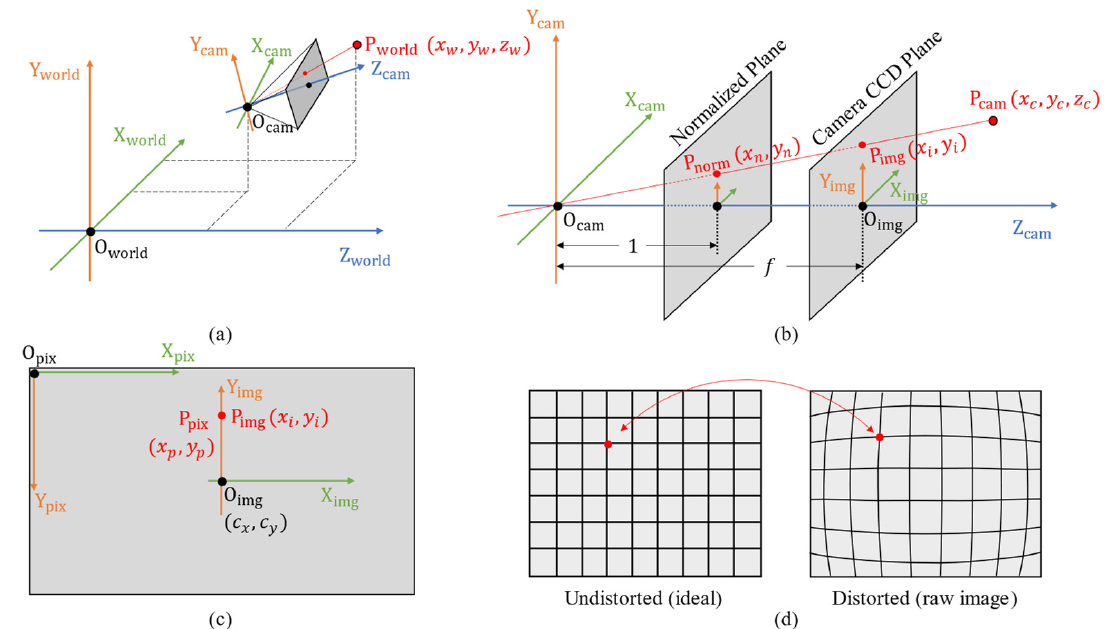
Figure 2. Example of reverse-calculating one point from the 3D world coordinates to the 2D pixel coordinates on raw UAV images by a pinhole camera model. ( a ) Relationship between world coordinate ( O world ) and camera coordinate ( O cam ), linked by camera external parameters (position and rotation). ( b ) Relationship between camera coordinate ( O cam ) and image coordinate ( O img ). ( c ) Relationship between image coordinate ( O img ) and pixel coordinate ( O pix ). ( d ) Camera distortion calibration between undistorted images and distorted images caused by the lens.